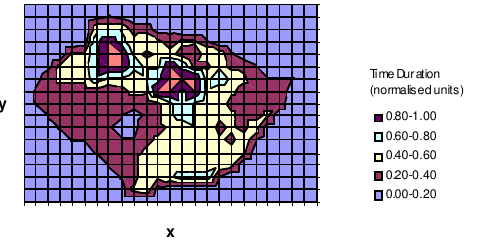
Figure 6(c). Side elevation of twin peaks showing degree of separation of two “apparent” stock camps for excretion sites.